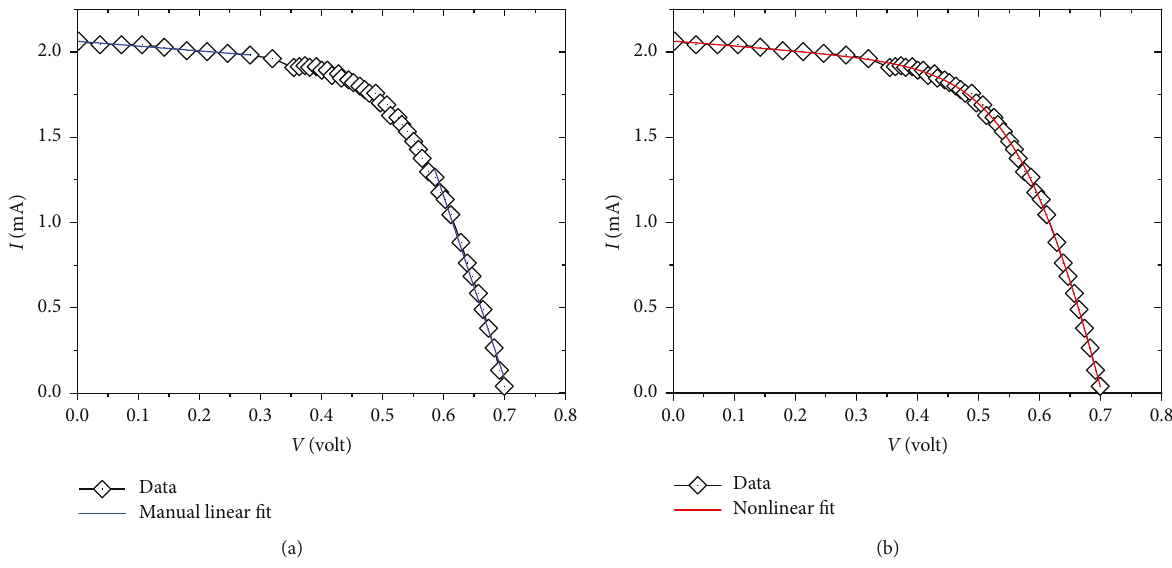
Figure 8: I-V curve fi t of DSSC: (a) manual method and (b) nonlinear curve fi